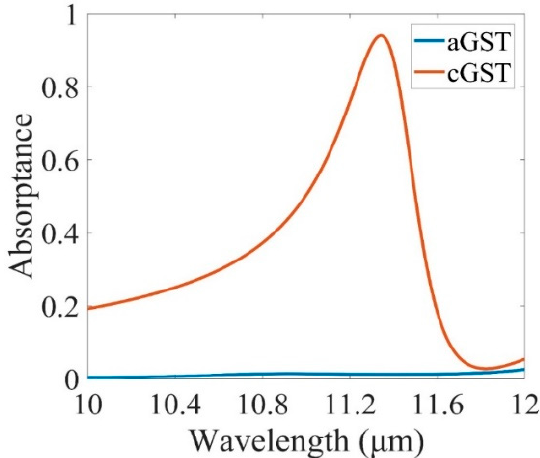
Figure 2. Total absorption at normal incidence for structure with amorphous (aGST) and crystalline (cGST) stable structural phases. The geometrical parameters are originally assumed as a = 0.3 μ m, h 1 = 0.53 μ m, h 2 = 0.81 μ m. Unless otherwise stated, they are used throughout the paper.